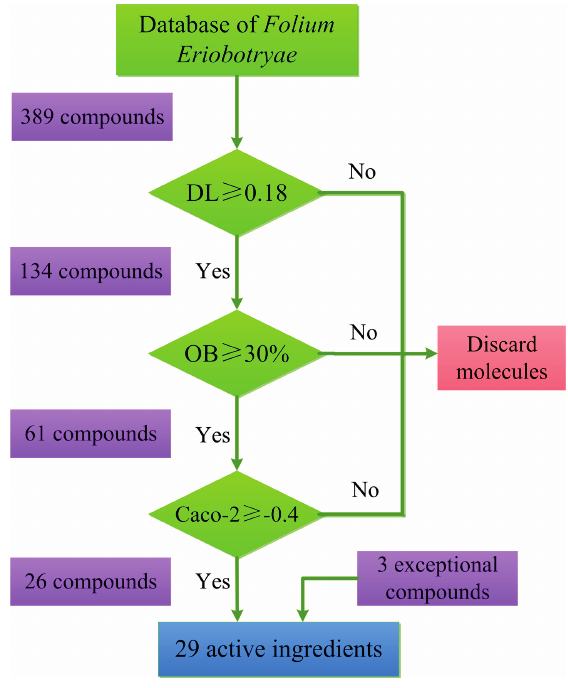
Figure 1. Active ingredients’ screening